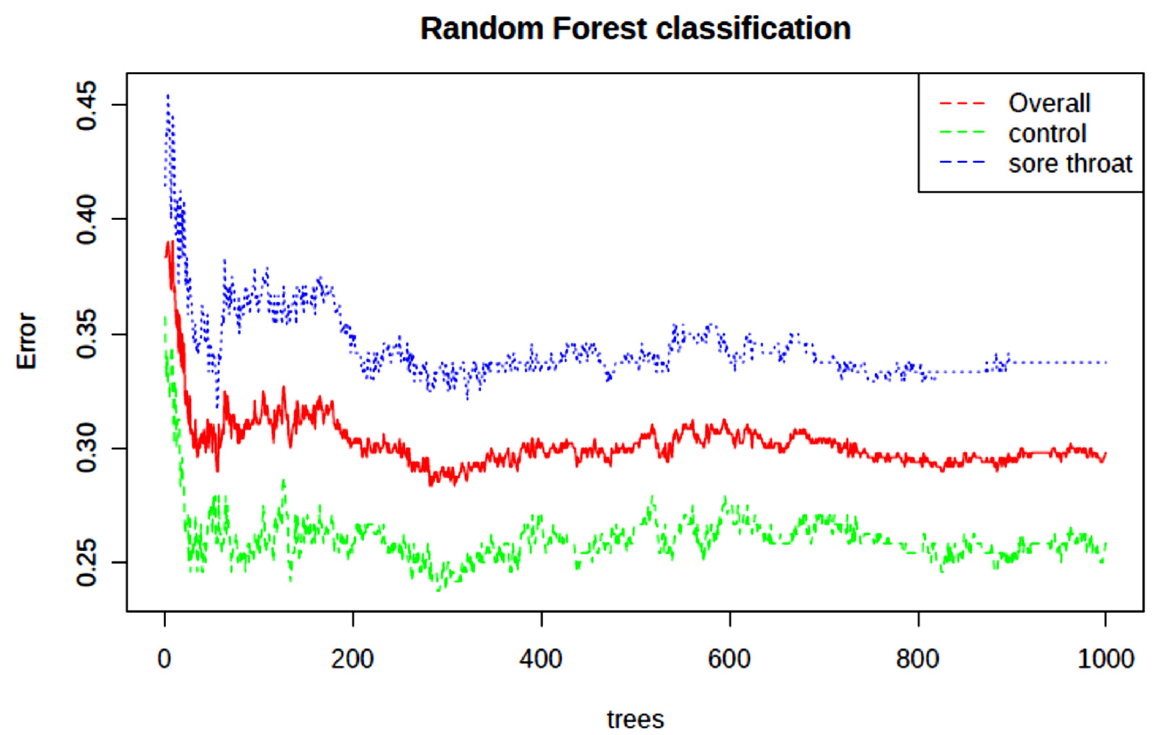
Figure 5. Random Forest plot of classification error versus number of trees incorporated into the analysis (Model 1) which was performed on all 31 named, assigned metabolites available. This dataset underwent TSP-normalisation, glog-transformation and Pareto-scaling prior to analysis, but without any further row-wise normalisation applied.